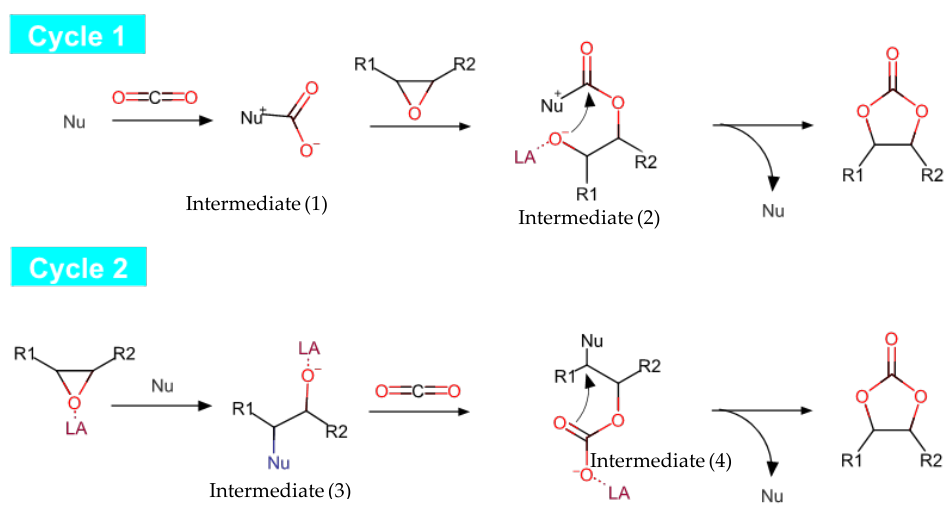
Figure 4. Reaction mechanistic pathways of cycloaddition of epoxide with CO 2 .